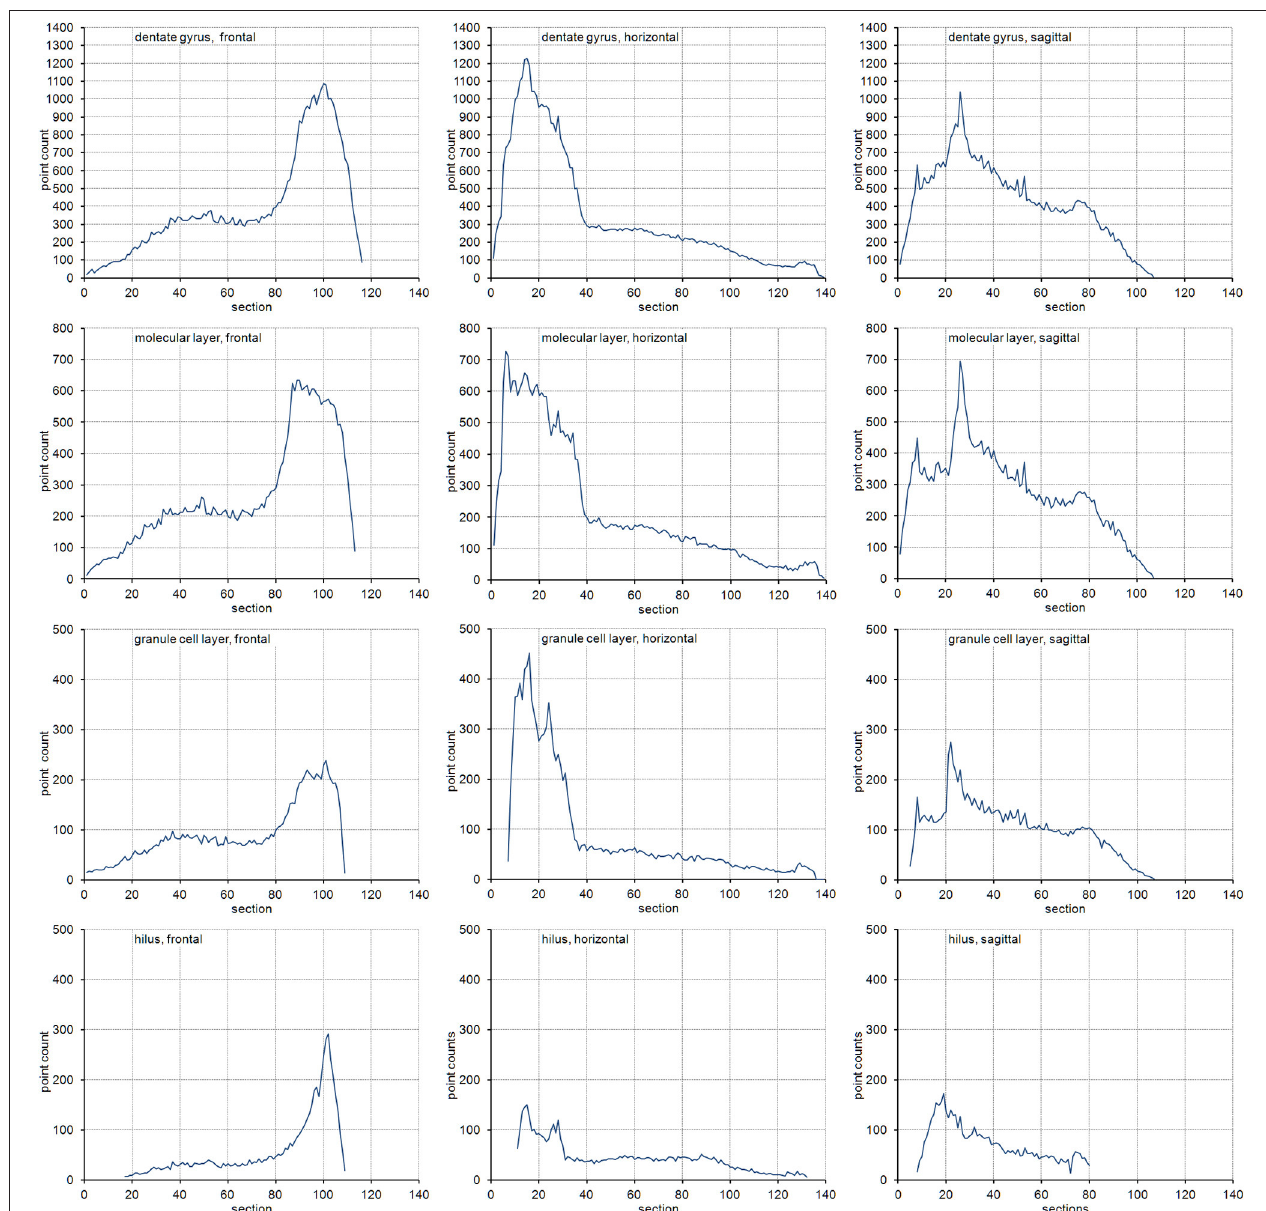
FIGURE 2 | Volume distributions of the dentate gyrus and its layers. Volume distributions are illustrated by the point count obtained in each section. Cutting directions are anterior to posterior for frontal sections, dorsal to ventral for horizontal sections and medial to lateral for sagittal